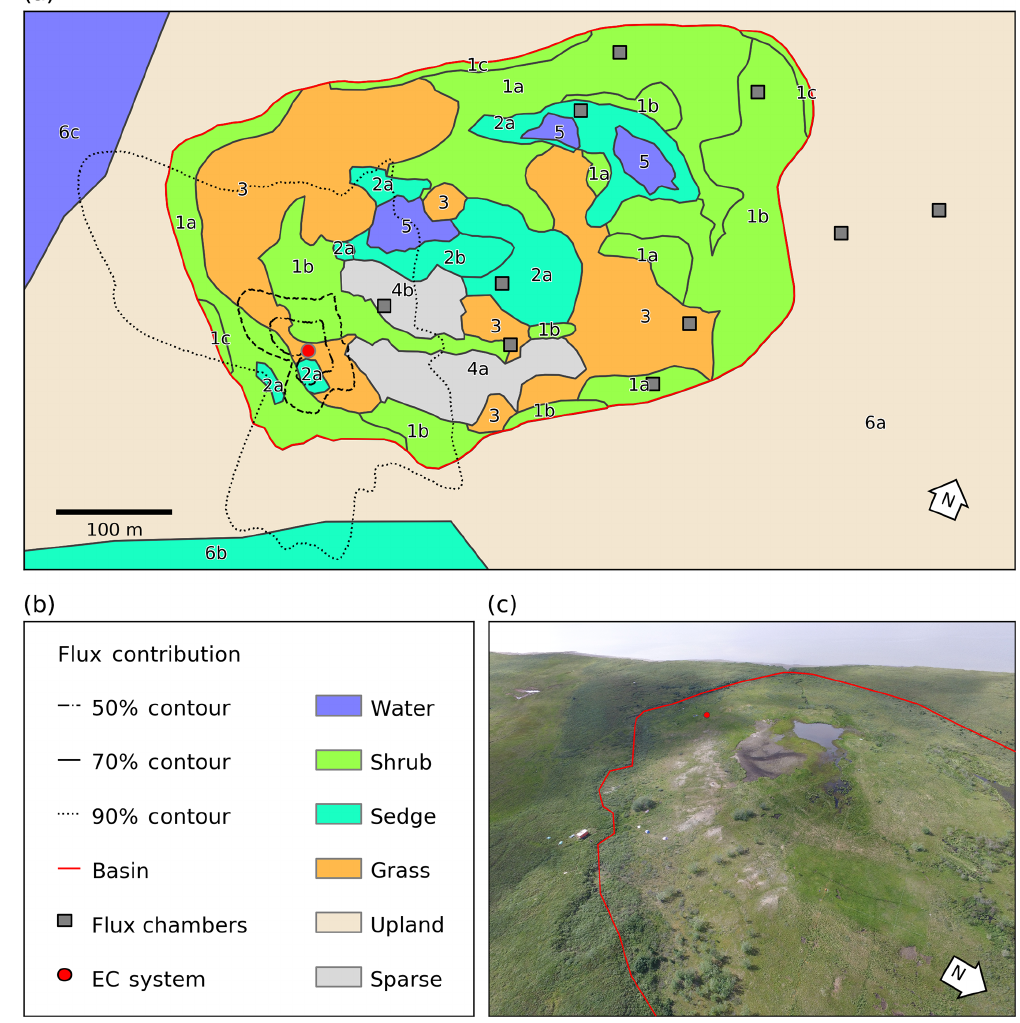
Figure 1. (a) Map of the distribution of vegetation classes at Illisarvik, with the footprint climatology ( F Clim ) over the study period, the locations of the chambers, and the eddy covariance (EC) system. The alphanumeric labels correspond to the unit codes in Table 1. (b) Legend for the map in (a) . (c) Oblique drone image of Illisarvik, taken at the 16:40 23 July 2016 view from E of DTLB towards W. The basin and EC system are shown on the image using the same symbology as (a)